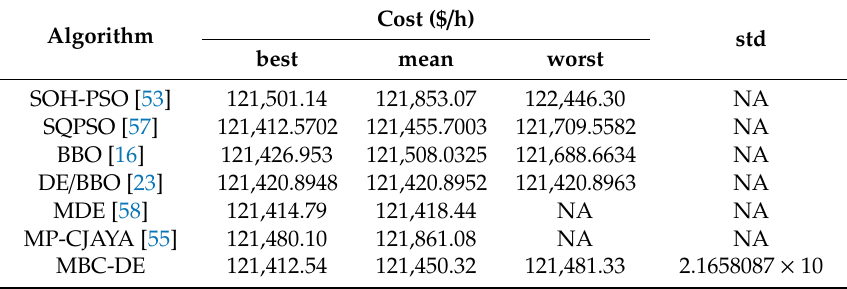
Table 13. Algorithm comparison between MBC_DE and other algorithms for test case 3.